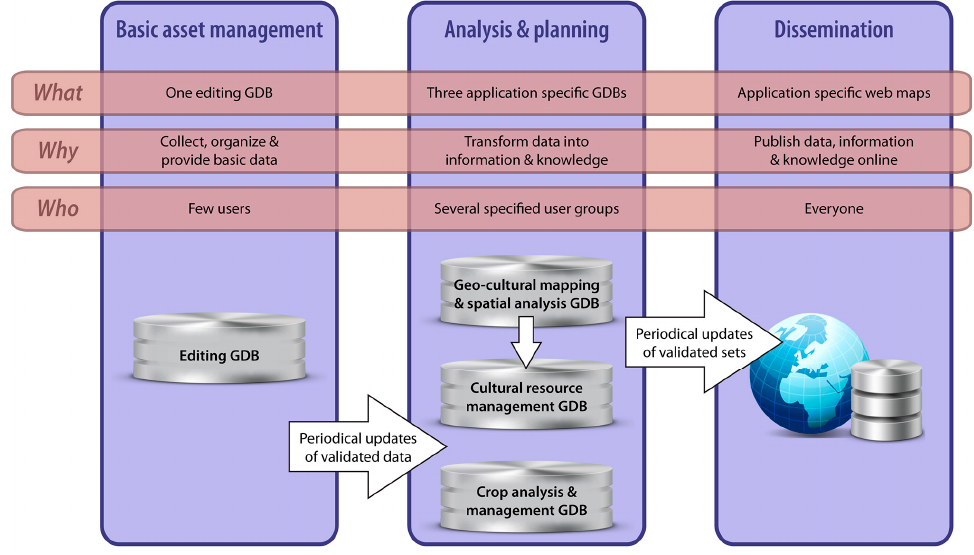
Figure 5. The proposed GIS framework: from data organisation to knowledge dissemination.